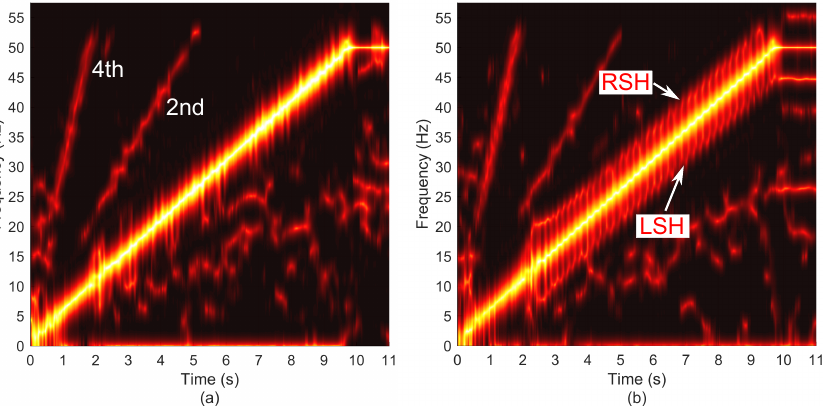
Figure 8. Time-frequency analyses of the IM stator current under startup transient and high-load level for: ( a ) healthy motor and ( b ) rotor with one full broken rotor